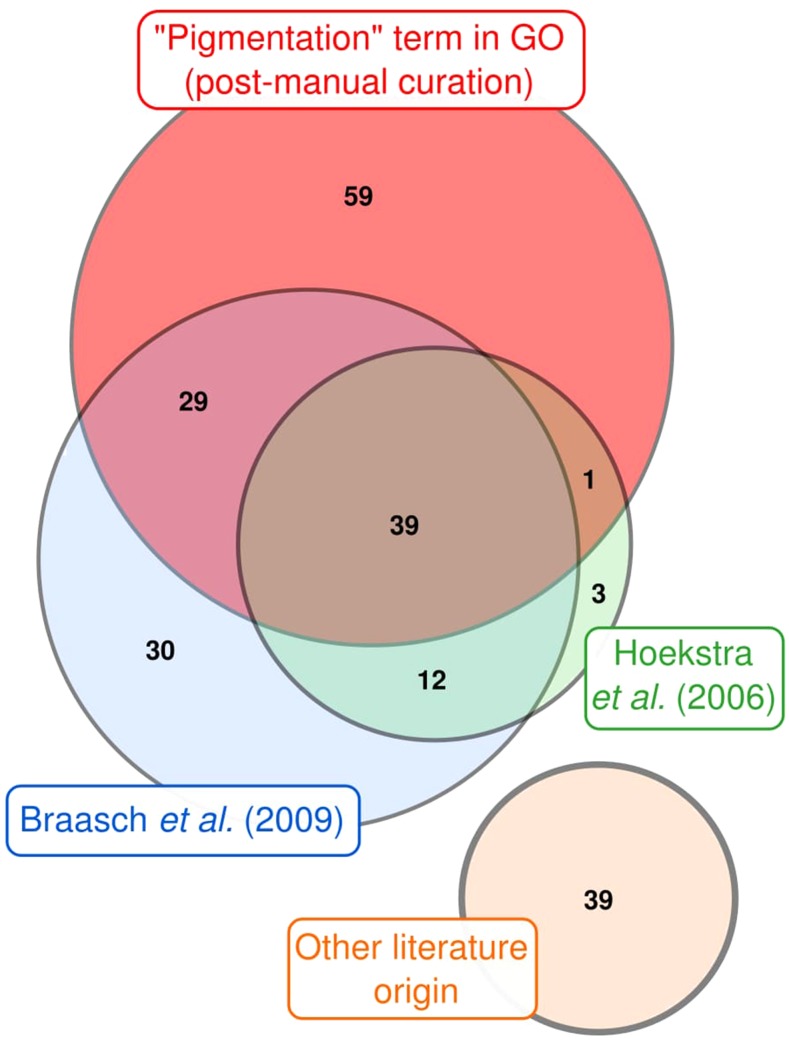
Origin of pigmentation genes studied in this work. Most PGs were either retrieved using the Gene Ontology term “pigmentation” (GO: 0043473) parsed for vertebrates (taxon id: 7742) or were previously cited in two studies (Hoekstra 2006; Braasch et al. 2009a). PGs described in more recent studies were also included (“other literature origin”). Numbers of genes are indicated. The Venn diagram was drawn using the BioVenn website (Hulsen et al. 2008).